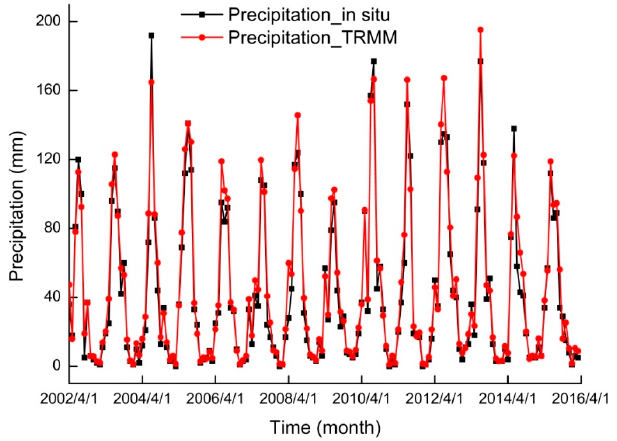
Figure 3. Comparison between the in situ precipitation from meteorological stations and the precipitation from satellite (TRMM 3B43) over the Liao River Basin from April 2002 to March 2016.